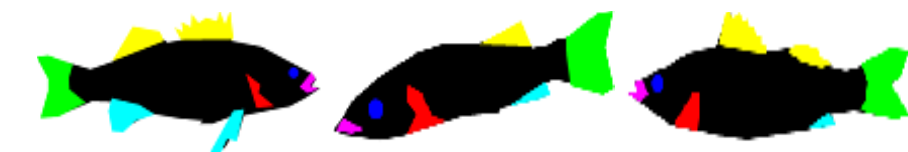
Figure 8. The fish patterns used for sea bass with colored parts.